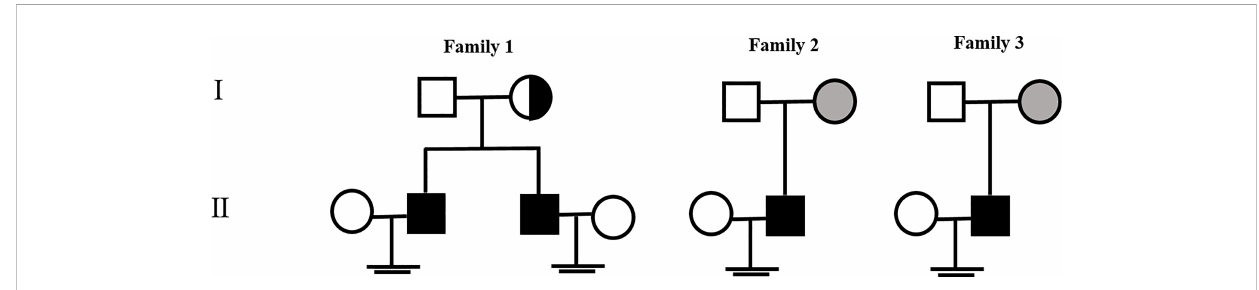
FIGURE 2 Family pedigree of the proband affected by NOA with a TEX11 mutation. The gray symbols indicate the patient ’ s mother who is the homozygous carrier of the TEX11 mutation, and the dotted-circle symbols indicate the patient ’ s mother who is the heterozygous carrier of the TEX11